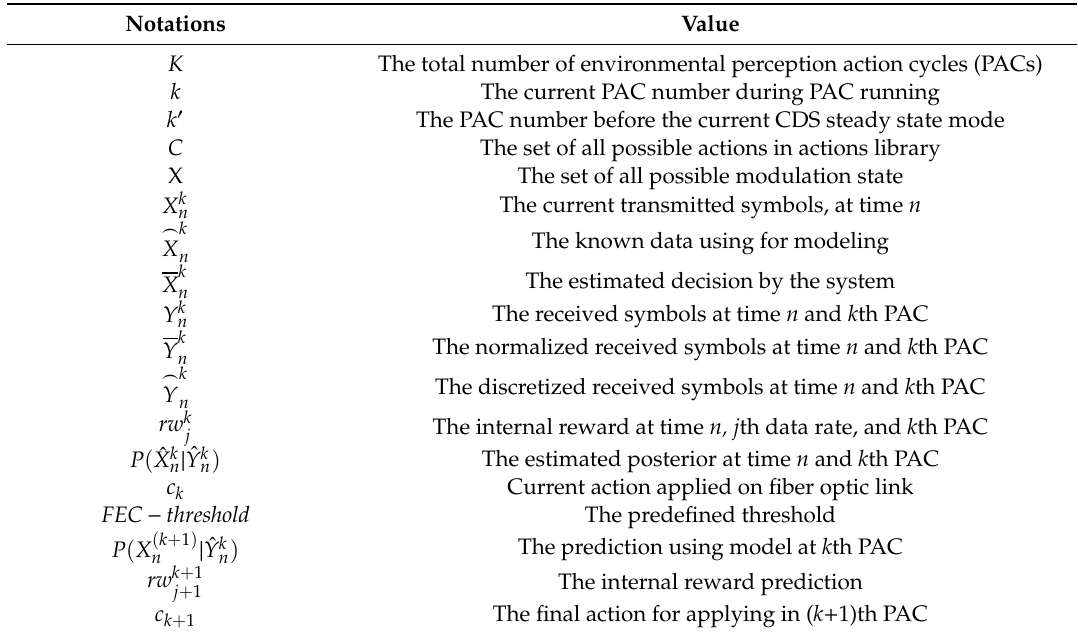
Table 3. The important notation list used in this